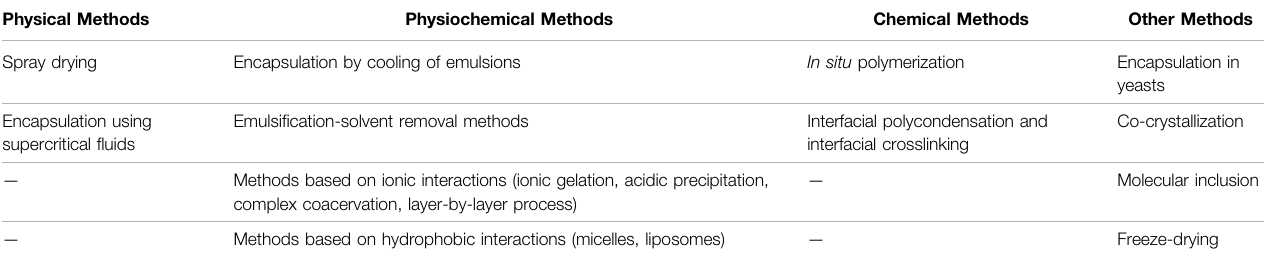
TABLE 2 | Classi fi cation and a short description of encapsulation methods used for active compounds (Munin and Edwards-Lévy,